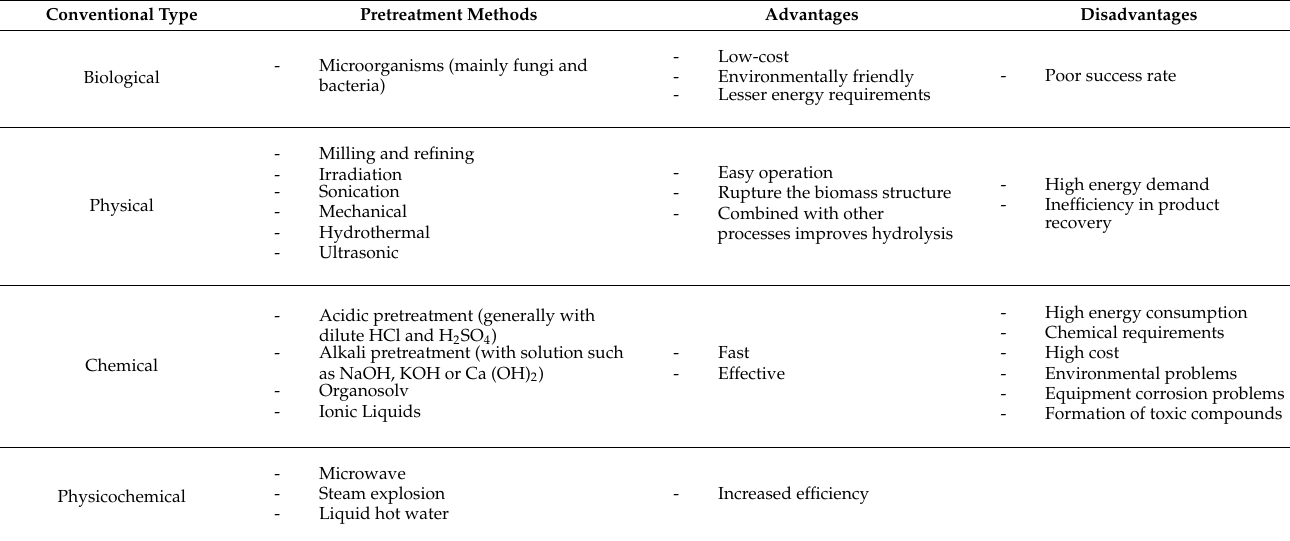
Table 1. Pretreatments applied in the biomass